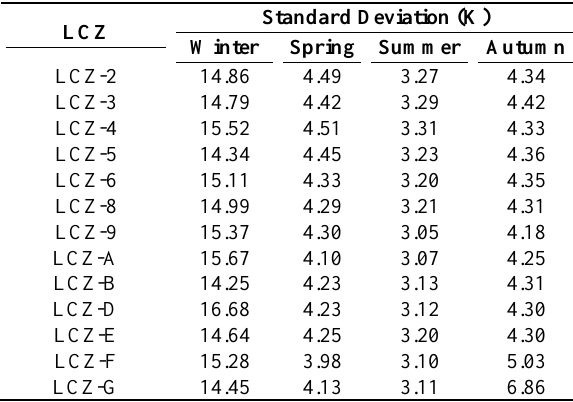
Table 3 . Standard deviation of the mean LST variations